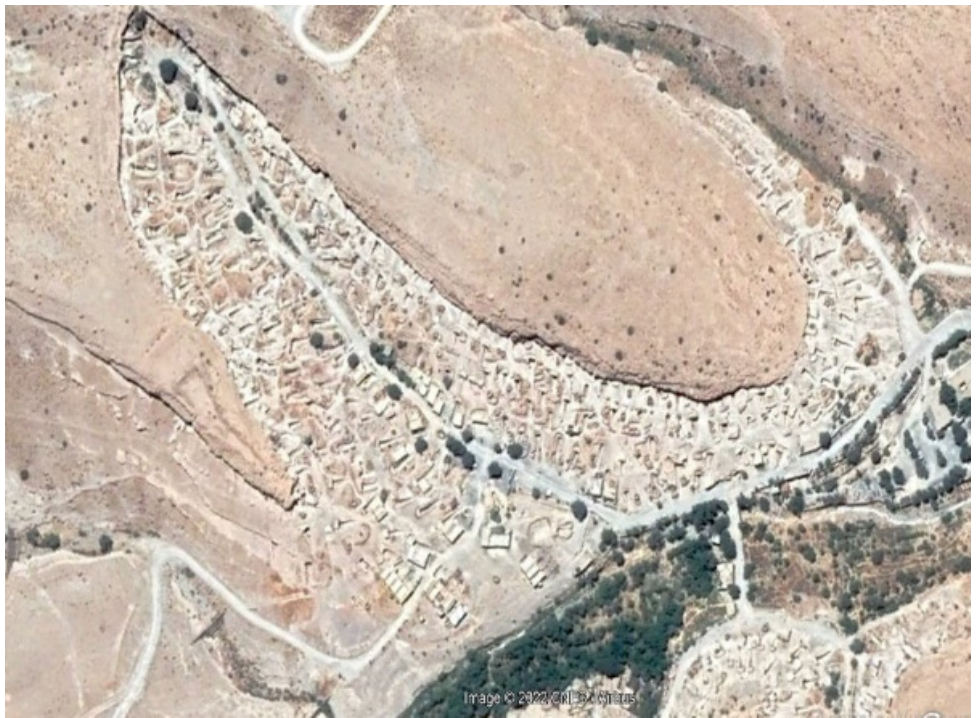
Figure 6. Aerial image of Meymand village.